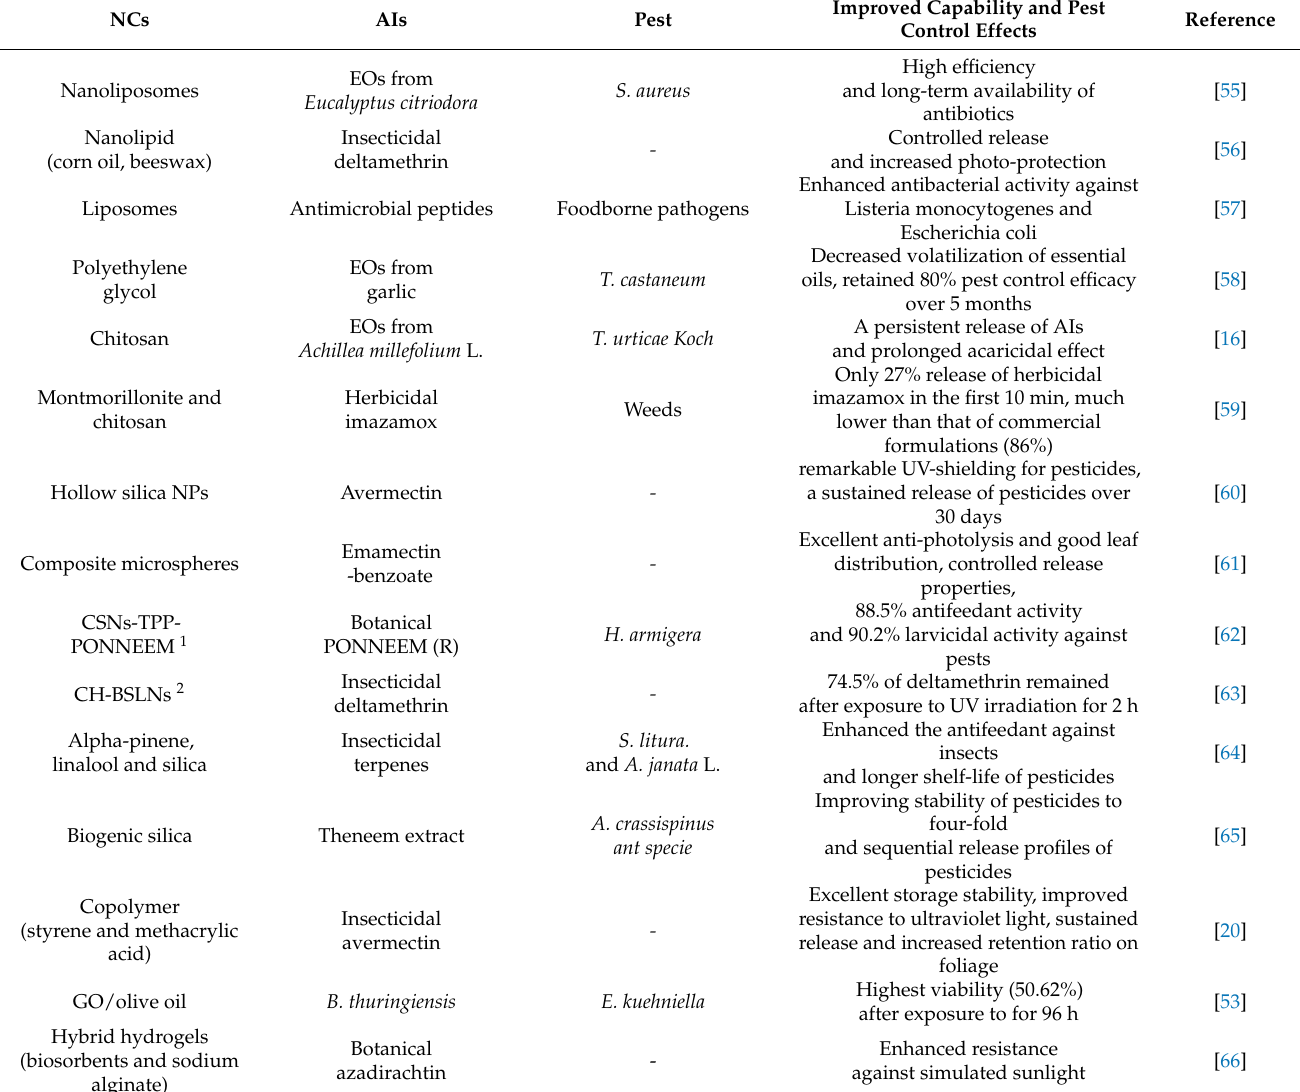
Table 2. Successful applications of using nanodelivery systems for slow, sustainable release of